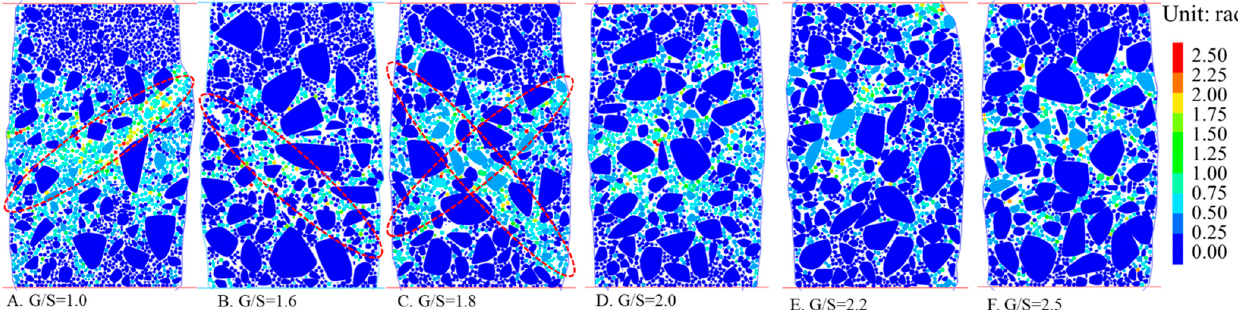
Figure 13. Sectional contour plots showing internal particle rotation for specimens with different G/S values upon shear failure.